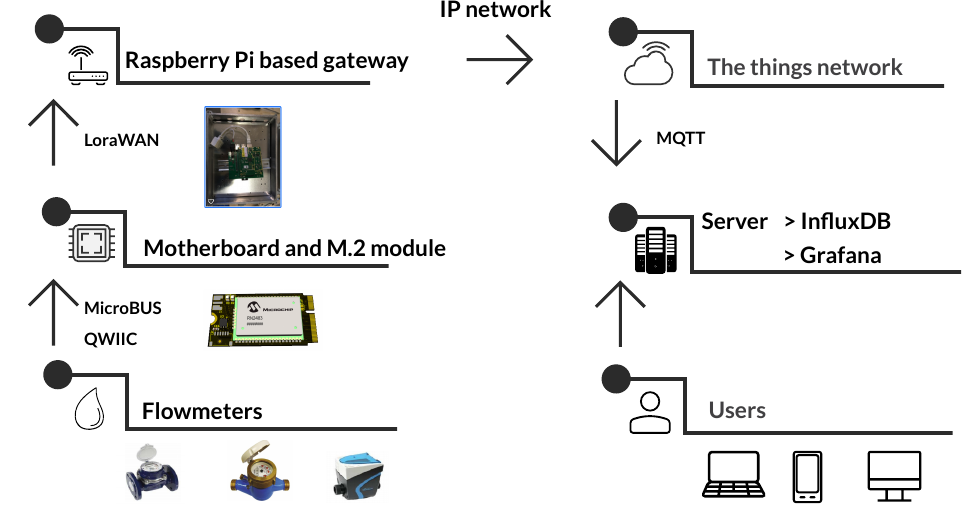
Figure 3. Concept of the proposed smart metering